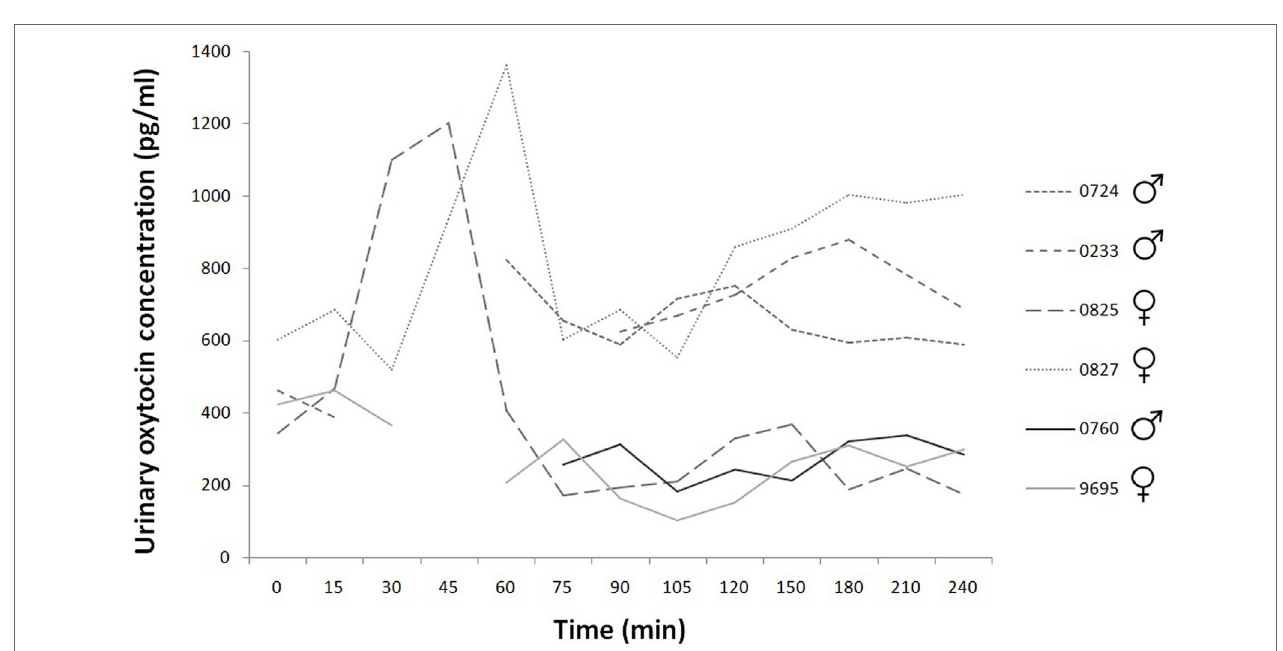
FigUre 2 | Time course of individual urinary oxytocin concentrations during the 240 min. Experimental group: dashed line; control group: continuous line.